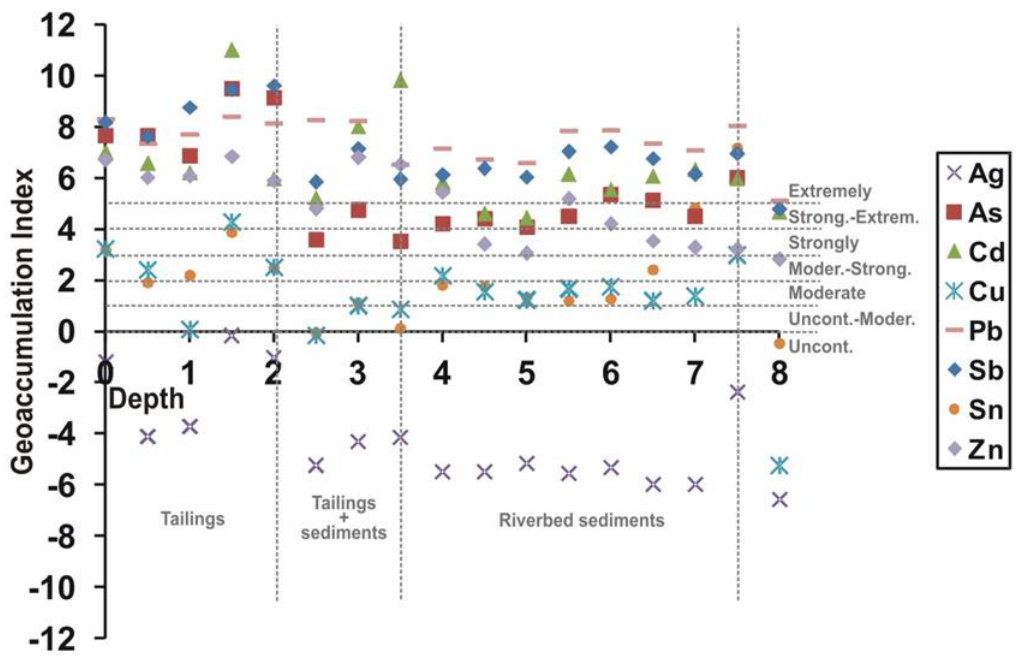
Figure 7. Variation at depth of the Geoaccumulation Index (I geo ) of metals and for the borehole samples.